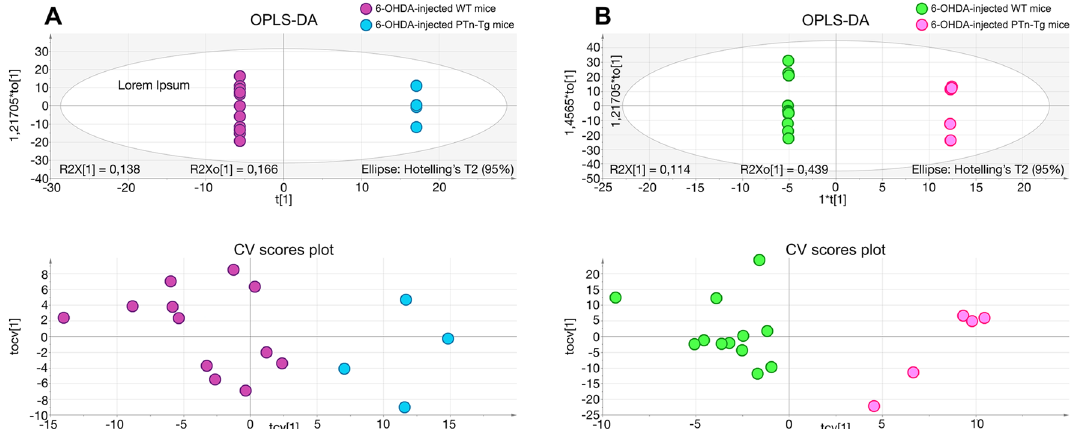
Figure 4. OPLS-DA regression models and cross-validated (CV) score plots showing differentiation of the metabolic profiles between 6-OHDA-injected Wt mice and 6-OHDA-injected Ptn -Tg mice in positive ( a , R 2 = 0.938, Q 2 = 0.699) and negative ( b , R 2 = 0.855, Q 2 = 0.796) ionization